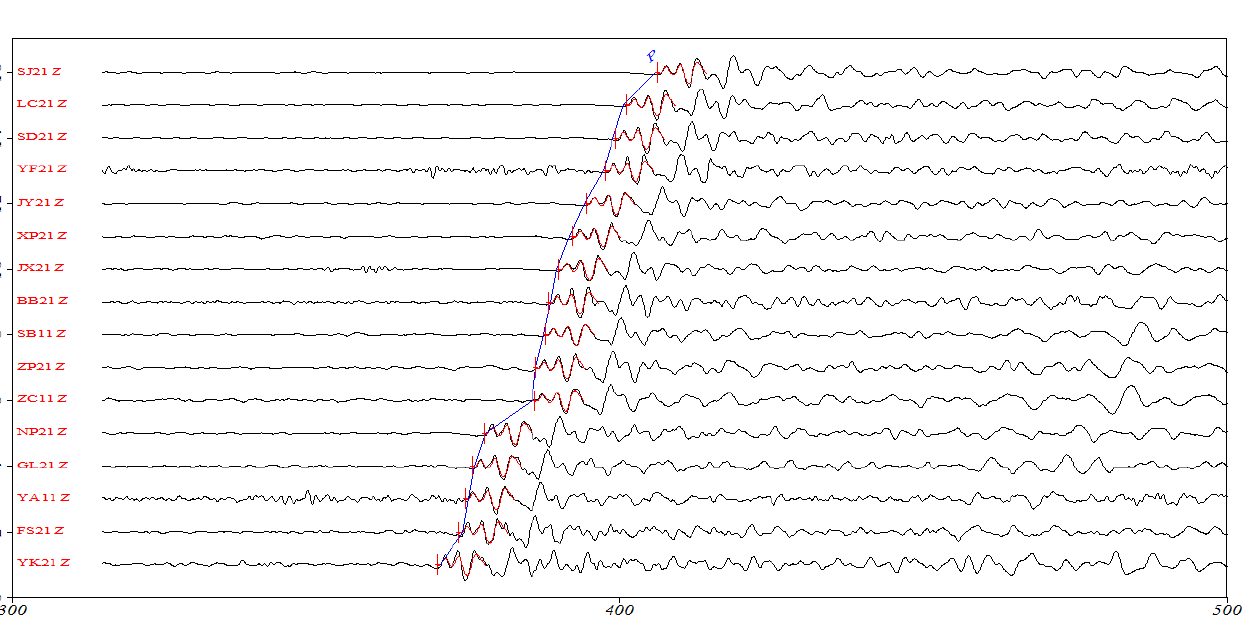
Figure 8. Cross-correlation results of Brazilian earthquake records.